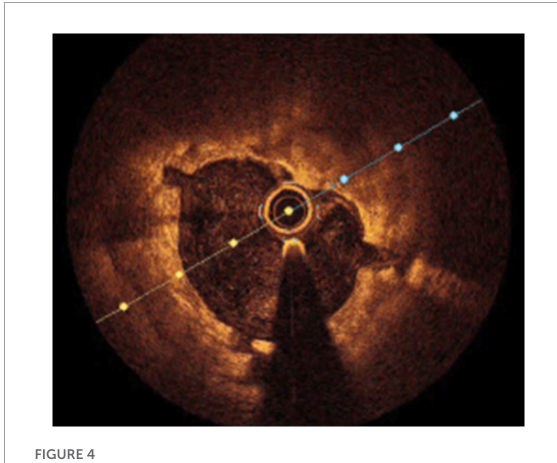
FIGURE5 Stent undersizing demonstrated at IVUS. The white dotted line marks the lamina externa, where the stent struts (*) should lie.